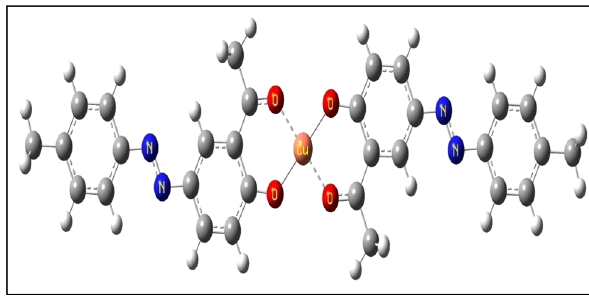
Figure 3: Optimized structure of Complex 2.